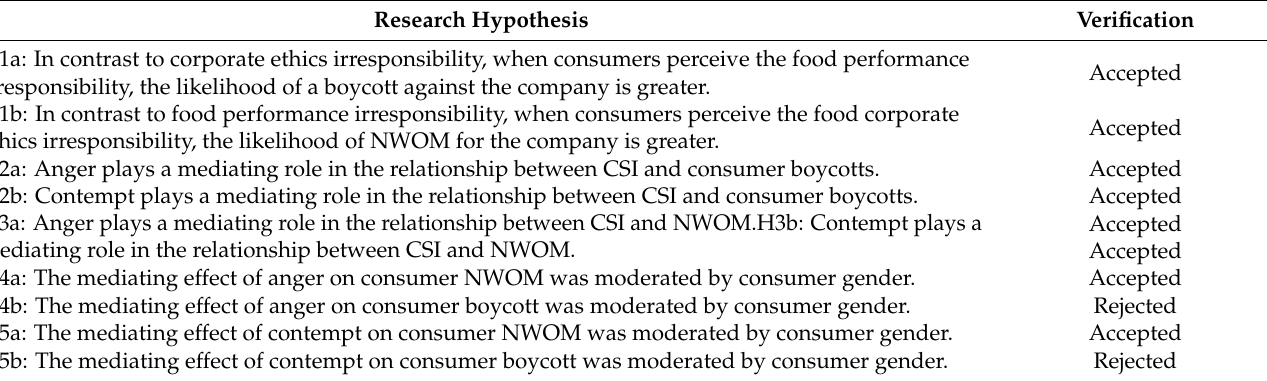
Table 8. Hypothesis verification summary. Research Hypothesis